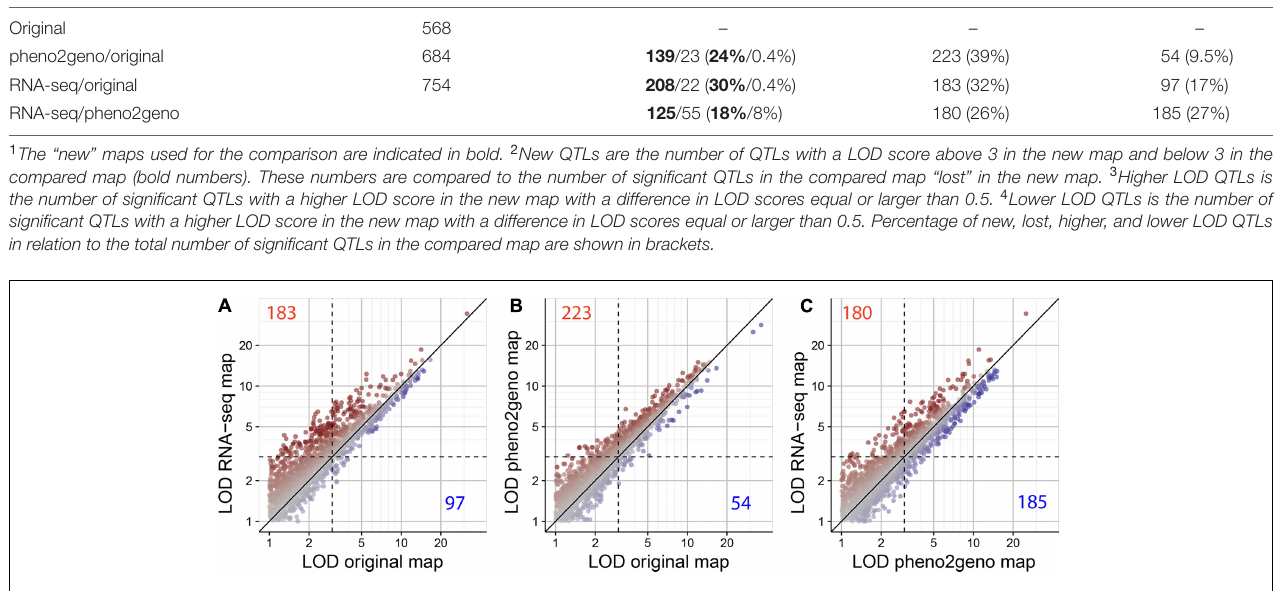
FIGURE 7 | LOD score comparison of QTLs for 2550 QTL peaks of 510 published phenotypes using the original, the pheno2geno, and the RNA-seq map. (A) LOD scores with the RNA-seq map versus the original map, (B) LOD scores with the pheno2geno map versus the original map and (C) LOD scores with the RNA-seq map versus the pheno2geno map. The significance threshold is indicated by a dashed horizontal and vertical black line. “Stronger” LOD scores are plotted in red. Red and blue numbers correspond to the number of significant QTLs identified on the x -axis map with increased or decreased LOD scores in the y -axis map,